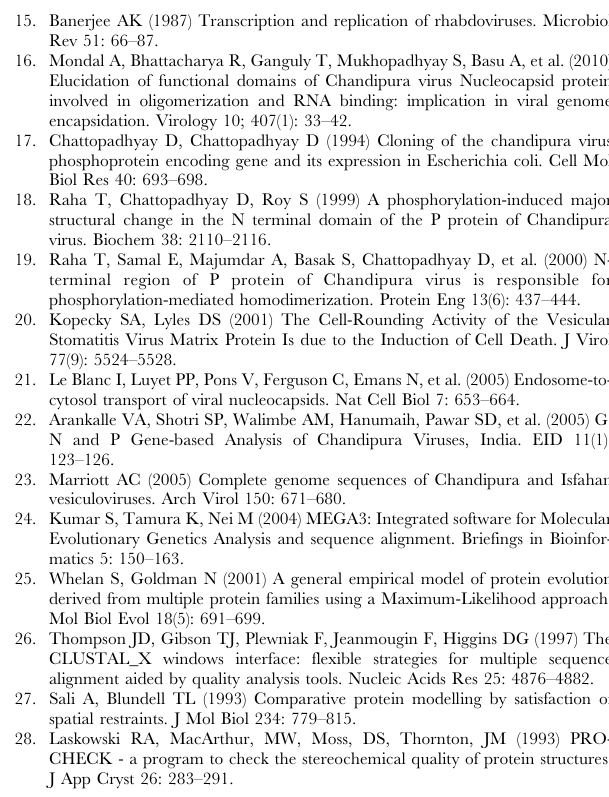
Figure S1 Protein-based phylogenetic trees of the genes of the CHPV whole genome isolates and other rhabdo- viruses using the Maximum likelihood method as implemented in MEGA. v.5.05. Bootstrap values greater than 60% are indicated at the appropriate nodes. Scale bar indicates number of nucleotide substitutions per site. Figure S2 Pairwise percent nucleotide identity (PNI) and percent amino acid identity (PAI) among CHPV whole genome isolates. Figure S3 Profile alignment of P protein of representa- tive CHPV isolates (indicated in bold) with other representative rhabdoviruses. All putative phosphorylation sites are underlined. The LC8 motif ([KR]XTQT) and the lysine rich motif (FSKKYKF) in lyssaviruses are highlighted in grey. The different domains defined for the P protein of VSV are indicated by arrows. The mutations within the CHPV isolates are indicated by downward arrows. Figure S4 Profile alignment of the L protein of repre- sentative CHPV isolates (indicated in bold) with other